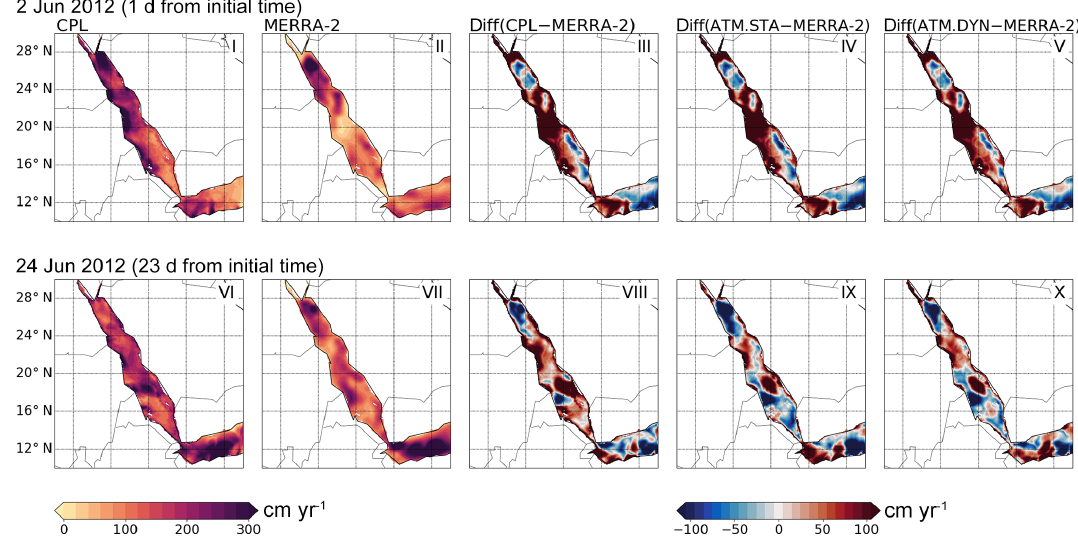
Figure B1. The surface evaporation patterns obtained in CPL, the MERRA-2 data, and their difference (CPL − MERRA-2). The differences between uncoupled atmosphere simulations with MERRA-2 (i.e., ATM.STA − MERRA-2, ATM.DYN − MERRA-2) are also presented. Two snapshots are selected: (1) 12:00UTC 2 June 2012 and (2) 12:00UTC 24 June 2012. Only the evaporation over the sea is shown to validate the coupled ocean–Atmosphere